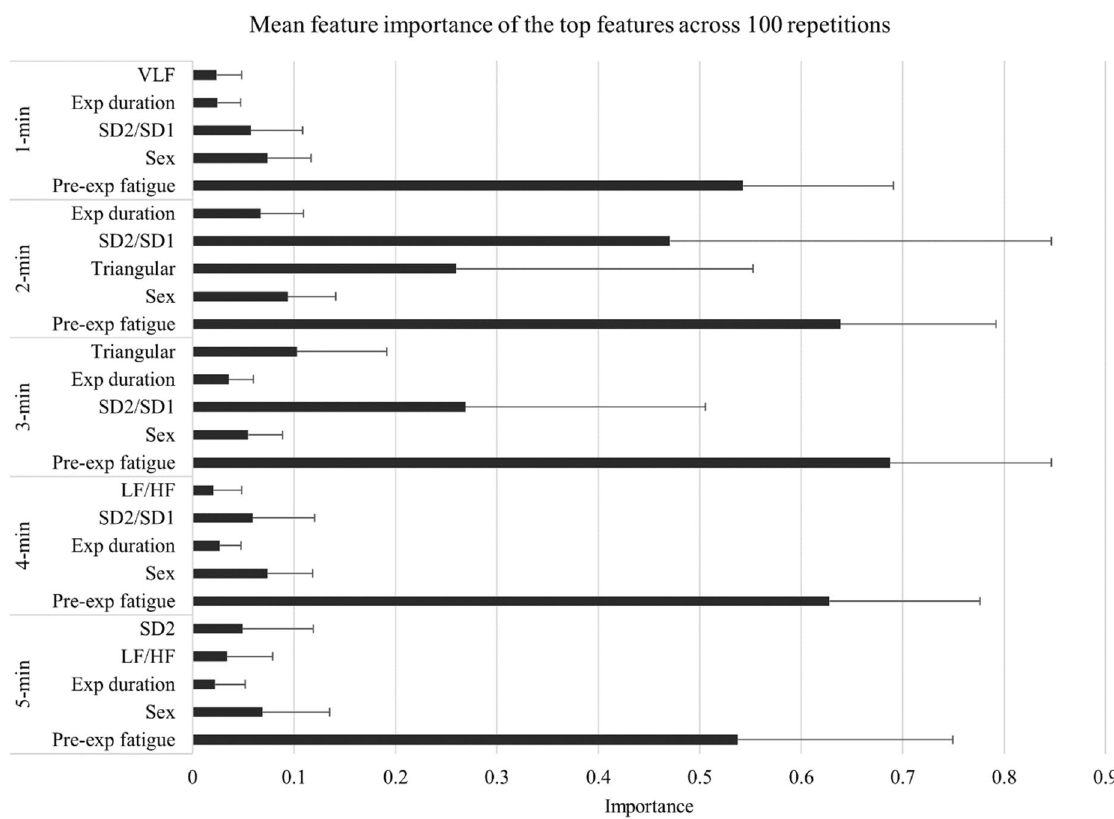
Figure 4. Importance values of the most frequently selected features for regression. Error bars represent 1 standard deviation. Exp duration duration of the experiment, LF/HF ratio of the low and high-frequency components, Pre-exp fatigue the level of subjective fatigue prior to the experiment, SD1/SD2 ratio of the width and the length of the Poincaré plot, SD2 the length of the Poincaré plot, Triangular HRV triangular index, VLF natural logarithm of the very low frequency